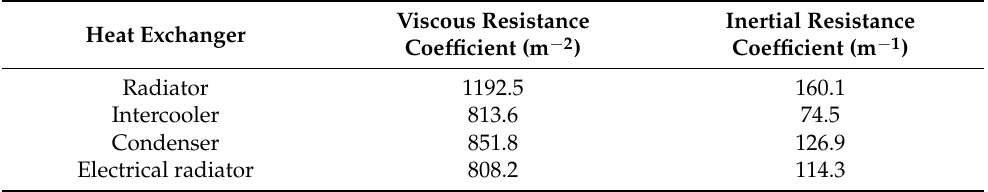
Table 1. The viscous resistance coefficient and inertial resistance coefficient of heat